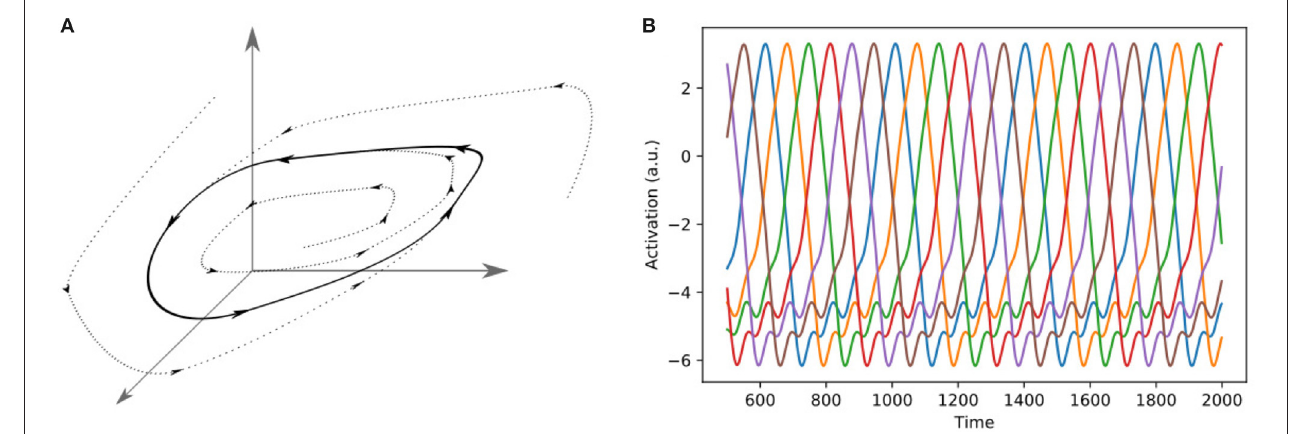
FIGURE 5 | Two different representations of a limit cycle. (A) A Limit cycle in three-dimensional phase space. In the case of a neuronal network, the dimensions of the phase space can be interpreted as the firing rates of the neurons. (B) Representation of a six-dimensional limit cycle as alternating activations of six different